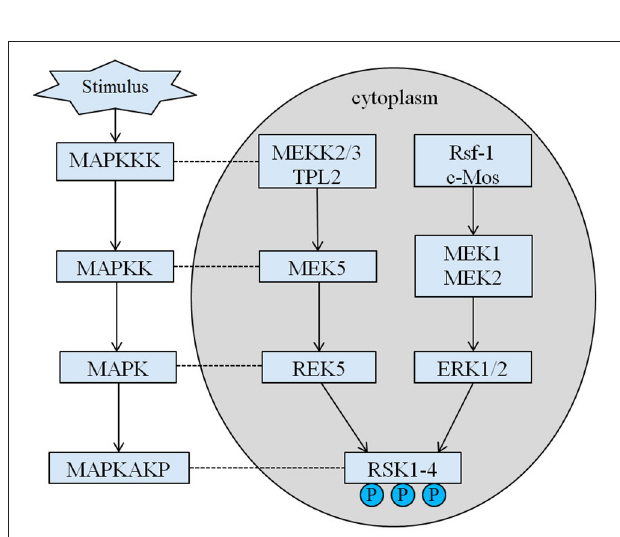
FIGURE 4 | The proposed pathway of RSK related genes. Multiple pathological stimuli, such as intrauterine malnutrition, trigger downstream signaling cascades of MAPK, which modulate the cell proliferation and bone mineralization.